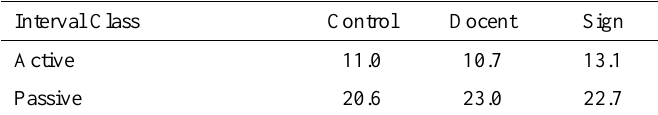
Percent of Intervals Containing Active Versus Passive Visitor Behavior Interval Class Control Docent Sign Active